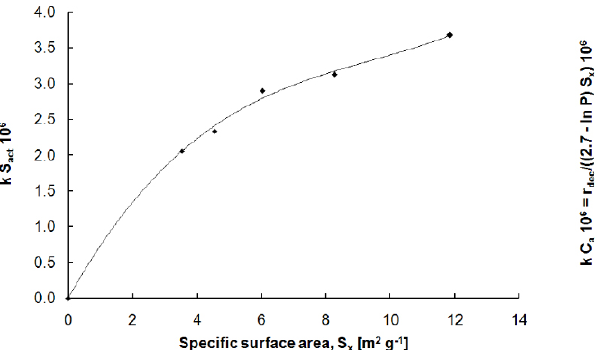
. Figure 5 Active surface area as a function of specific surface area. Figure 6. Concentration of active sites on the surface of catalyst